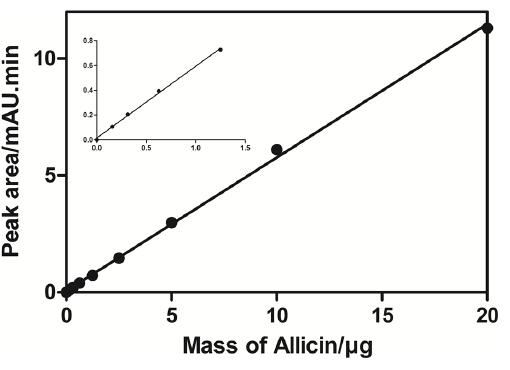
Figure 3. Calibration curve of aqueous allicin standard (AAS). AAS of known concentrations (8–1000 m g/ mL) were used to produce a calibration curve which was then used to quantify the allicin present in the fresh AGE preparations. The peak area for allicin was linear over 0–20 m g of allicin loaded onto the column (r 2 5 0.9987 and gradient 0.57 ¡ 0.01 mAU.min. m g 2 1 ).